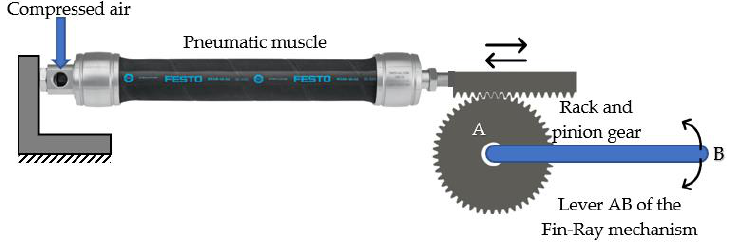
Figure 4. Actuation system of joint A.